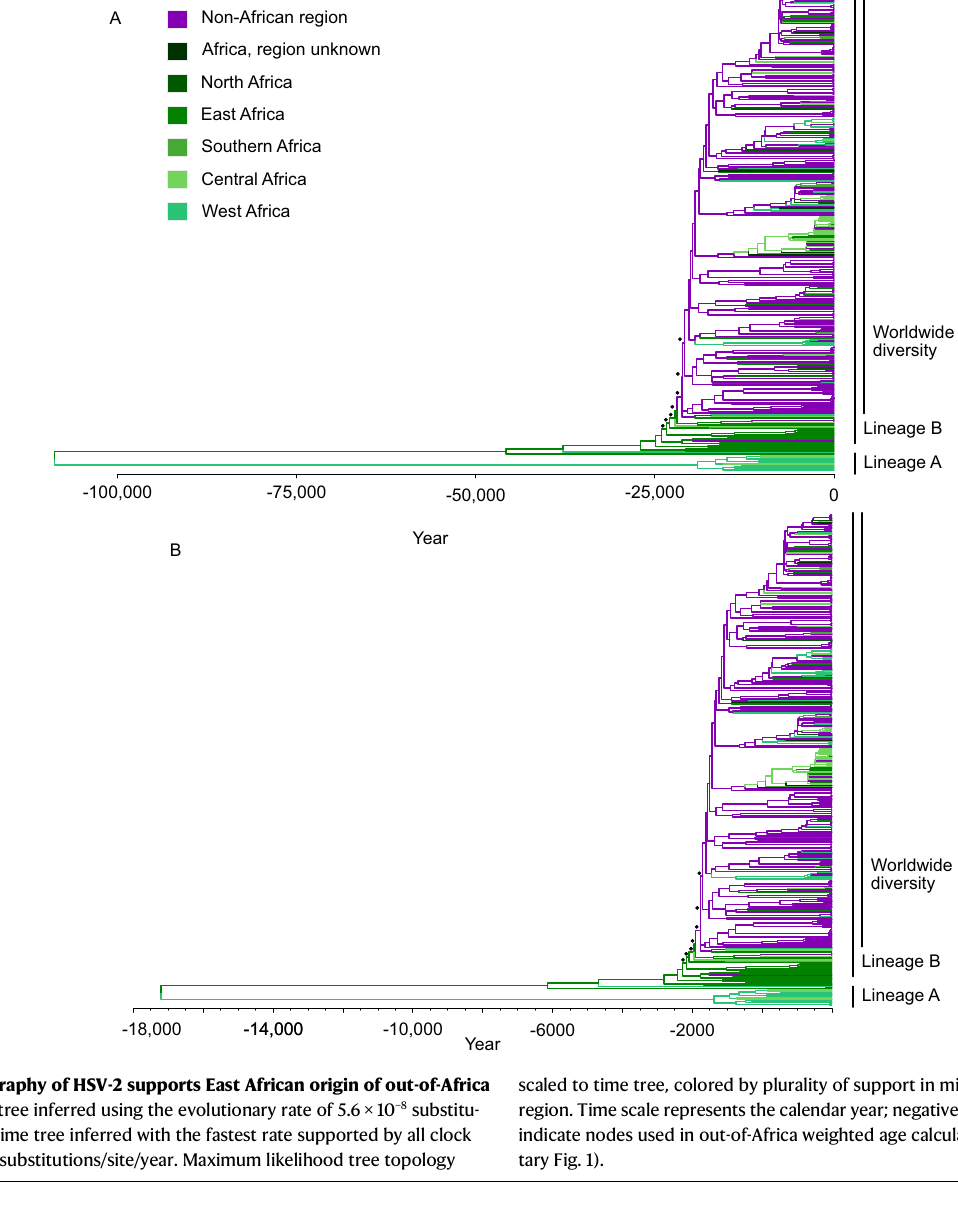
Fig. 4 | Phylogeography of HSV-2 supports East African origin of out-of-Africa dispersal. A Time tree inferred using the evolutionary rate of 5.6×10 − 8 substitu- tions/site/year. B Time tree inferred with the fastest rate supported by all clock analyses: 3.2×10 − 7 substitutions/site/year. Maximum likelihood tree topology